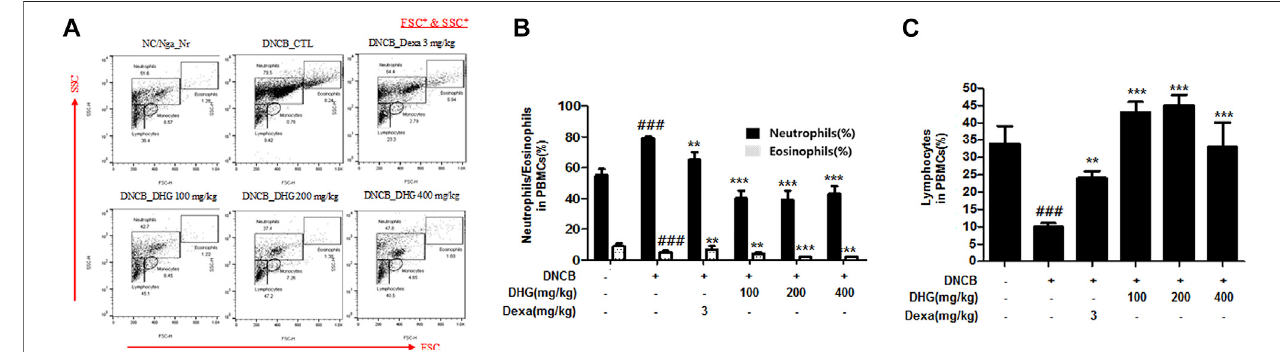
FIGURE 4 | The effects of DHG on the percentage of neutrophils , eosinophils, and lymphocytes changes of total cell content numbers in PBMCs in NC/Nga mice (total n = 6/group). Total cell content of FSC + and SSC + in PBMCs (A) . PBMC cells (5 × 10 5 cells/mL) were isolated from blood and the PBMCs were washed twice and